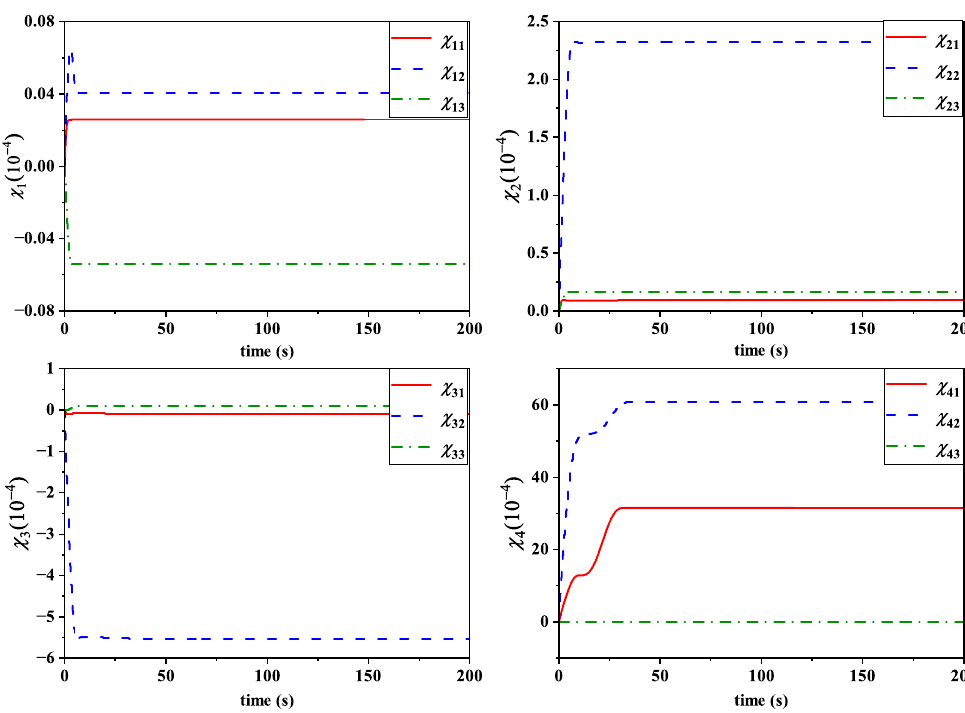
Figure 7. The evolution trajectories of adaptive parameter χ i . With the parameters k ε = 0.5, k µ = 1, ξ = 1 and µ i ,max = 0.005, the variable structure adaptive ChNN-based approximator can estimate the bounded nonlinear terms and uncer- tainties online. The parameters k ε , k µ , ξ belonging to the hyperbolic tangent function not only have an impact on the control accuracy, but can also effectively alleviate the chattering caused by the signum function. As mentioned earlier, to make up for the poor approxima- tion ability at the learning phase of the ChNN, the adaptive ChNN-based approximator takes effect only when (cid:107) (cid:99) M i Γ i (cid:107) ≤ µ i ,max ; its functional effect is reflected by the switching function m i ( t ) . In addition, a filter G ( s ) = 1/ ( Ts + 1 ) , T = 0.1 acting on m i ( t ) can